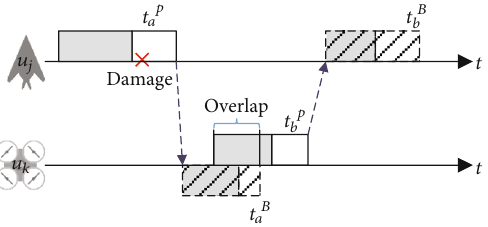
Figure 6: Illustration example for Property